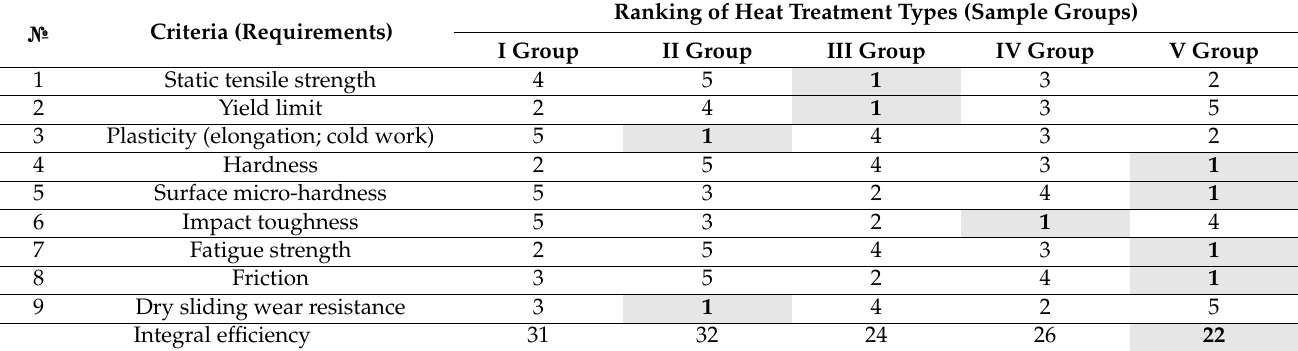
Table 3. Comparison of the effectiveness of the types of heat